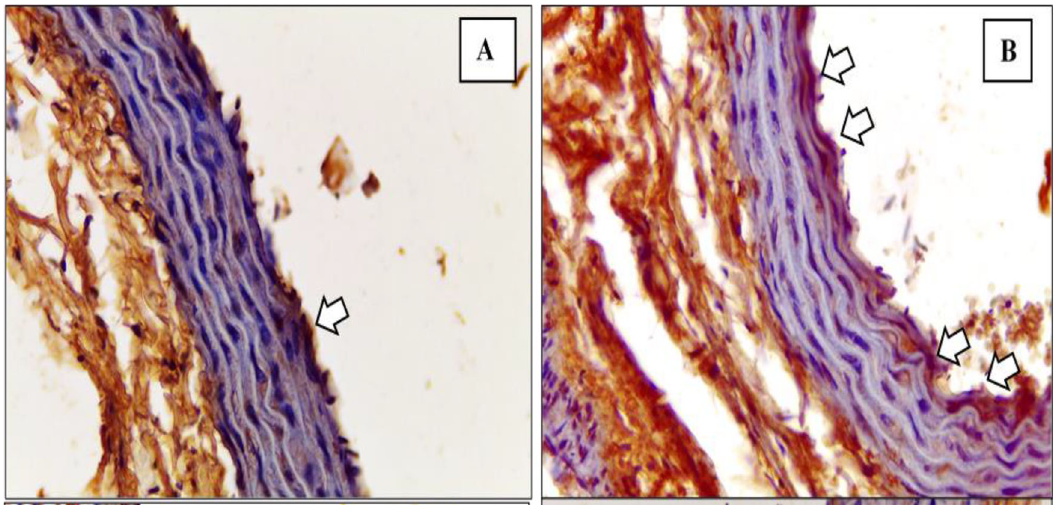
Figure 4. Immunohistochemical staining of M2 expression by Egr-2 (white arrow) on (A) Negative control (B) Positive control.